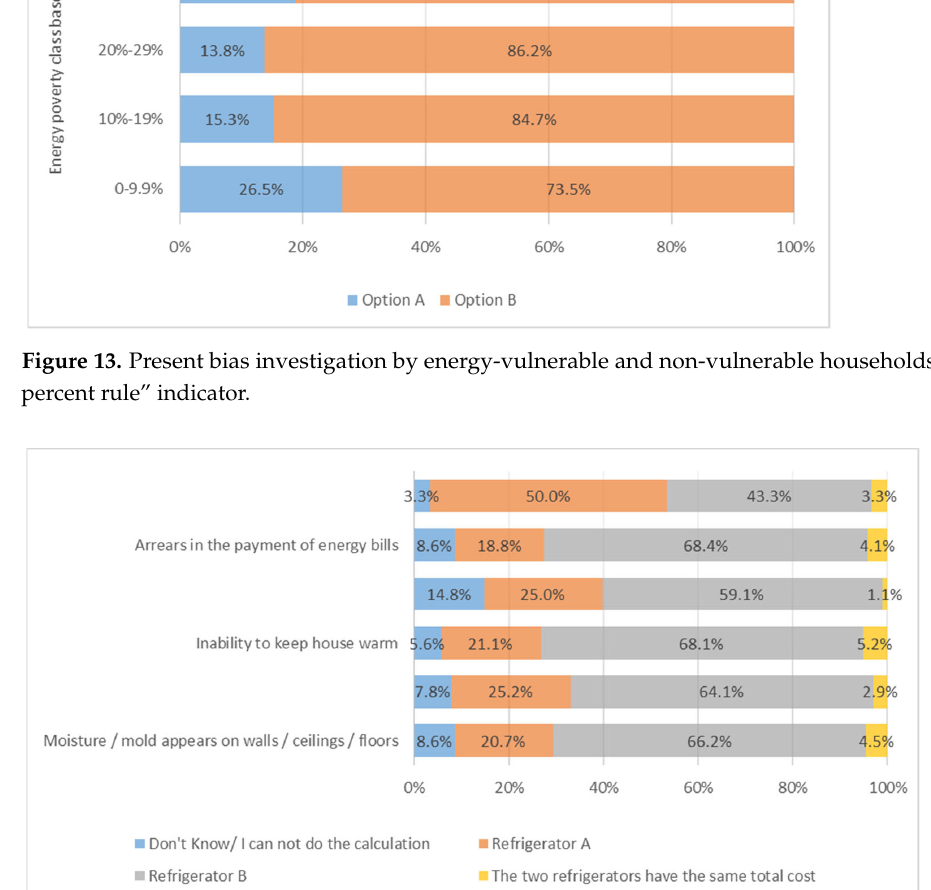
Figure 15. Energy ‐ related financial literacy investigation by energy ‐ vulnerable and non ‐ vulnerable households—“ten percent rule” indicator. For conciseness reasons, only the findings of the statistical tests are discussed here ‐ inafter. The analysis is presented by statistical hypothesis to facilitate the drawing of con ‐ clusions. 4.4.1. Energy Vulnerability and Financial Barriers According to the Mann–Whitney test, those who cannot keep their houses adequately warm (U = 6796, p = 0.000) and have arrears on energy bills (U = 3109, p = 0.025) face a lack of financial means that prevents them from taking energy ‐ saving actions compared to those who do not have these difficulties. On the contrary, there is no statistically signifi ‐ cant difference at the 5% level between those reporting and not reporting moisture or mold problems (U = 8961, p = 0.081). Furthermore, energy vulnerability determined by the “ten percent rule” also seems to be connected with the existence of financial barriers to improving energy efficiency. The null hypothesis of the Kruskal–Wallis test (i.e., the samples originate from the same distribution) is rejected ( χ 2 = 27.481, df = 4, p = 0.000). As expected, the higher the mean